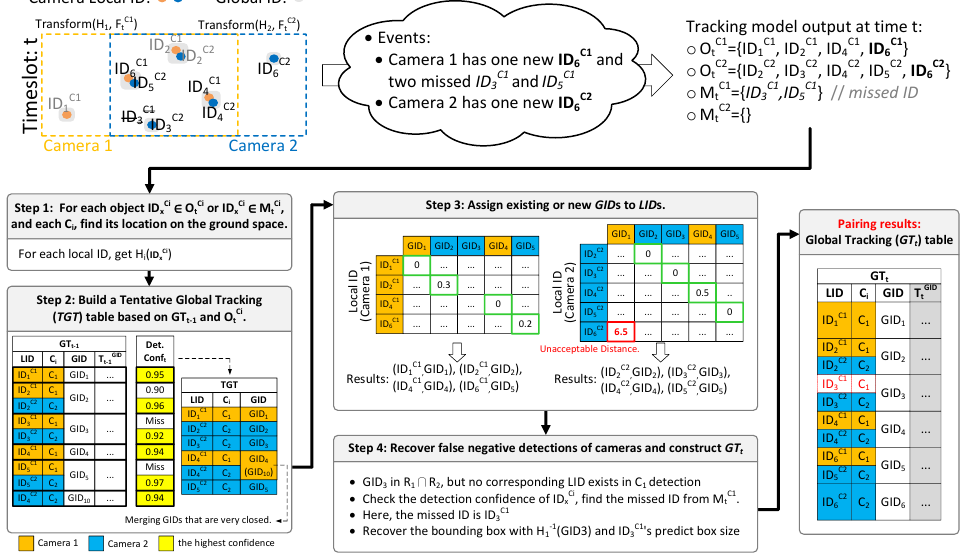
Figure 4. An example of creating GT t from GT t − 1